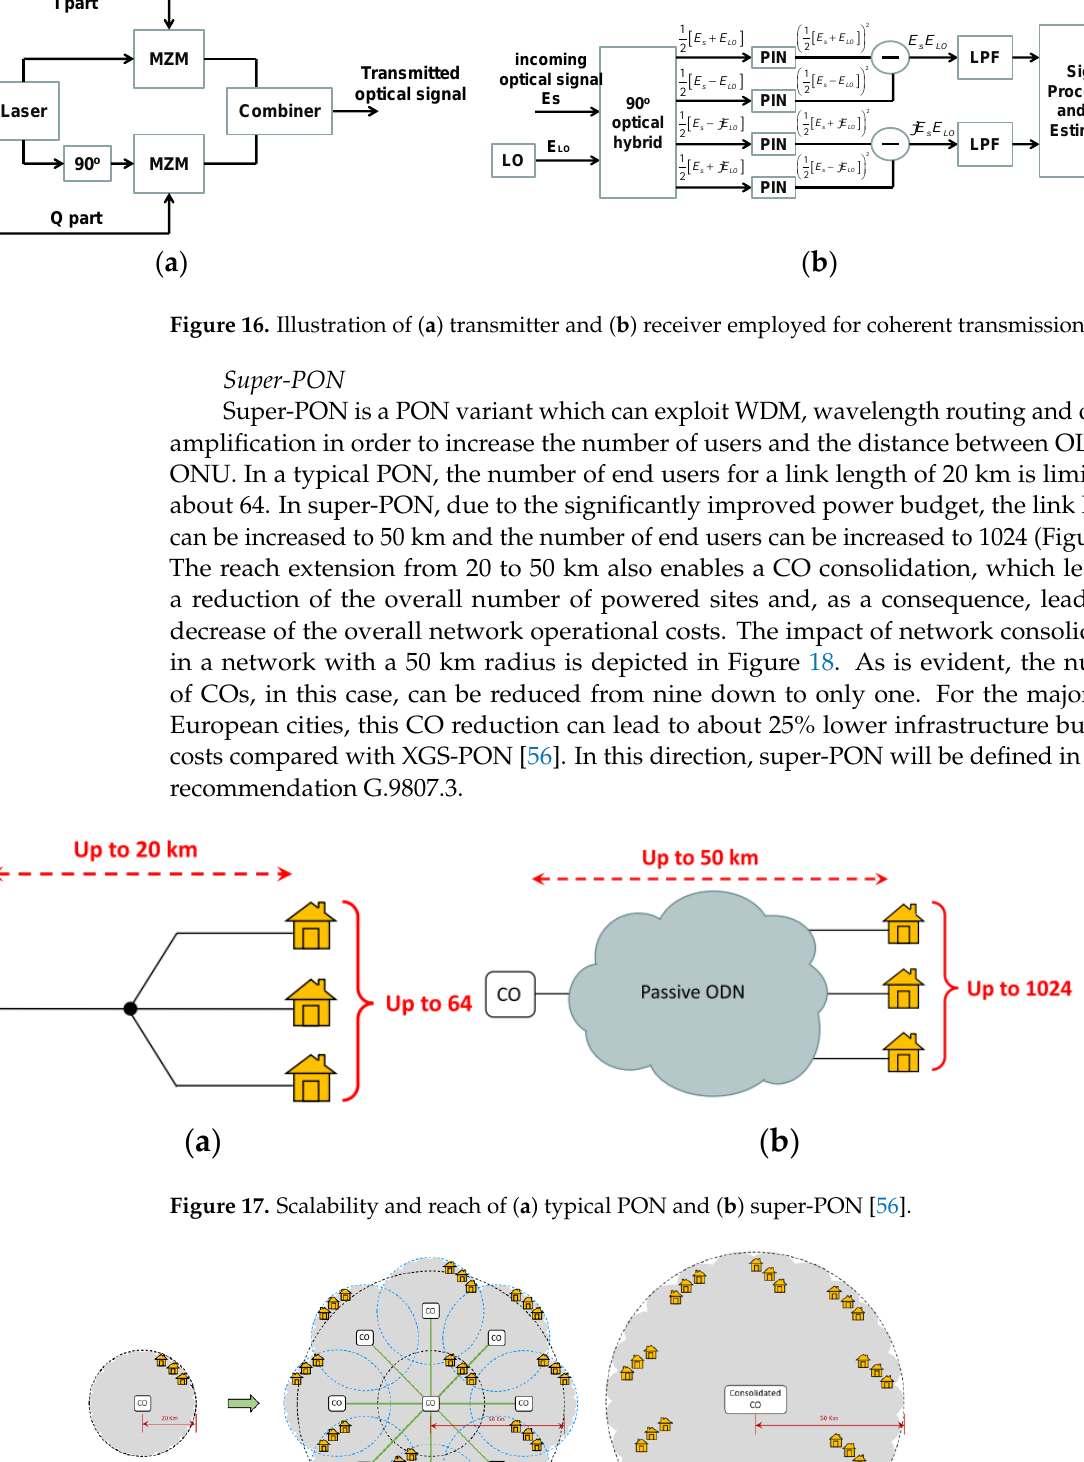
28 Figure 15. OCDMA-PON architecture. Coherent-PON Coherent transmission has been widely commercialized for long-haul communica- tions, but in the access domain, it is considered a cost-ineffective solution [54,55]. How- ever, as the traffic demands scale over time, coherent transmission with low-cost modules seems appealing for the near future, as it can greatly increase the number of supported users as their signals can be transparently multiplexed in the optical domain. Coherent-PON provides a number of well-known advantages. First, the coherent transceivers can attain an increased power budget compared with their DD counterparts, due to the improved receiver sensitivity, directly leading to an increase in both the num- ber of users and the transmission reach. In practice, the increase in power budget using coherent transmission can be higher than the one attained with an APD or with an optical amplifier. Second, the spectral efficiency can scale flexibly due to the use of quadrature amplitude modulation (QAM) shaped signals. The use of a higher-order constellation in- stead of an increased number of components, directly reduces the overall costs and power consumption. Third, the channel selectivity can be finely tuned by simply adjusting the local oscillator (LO) at the receiver and the electrical filter. Fourth, if digital signal pro- cessing (DSP) is employed, the impact of various performance constraints, such as chro- matic dispersion, polarization mode dispersion and various component imperfections, can be mitigated concurrently, but with an additional cost, due to the expensive ad hoc application-specific integrated circuits (ASICs) for DSP and coherent optics [52]. These